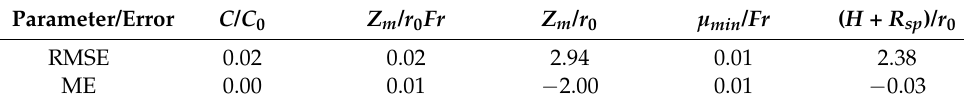
Table 4. Root mean square error (RMSE) and mean error (ME) for different